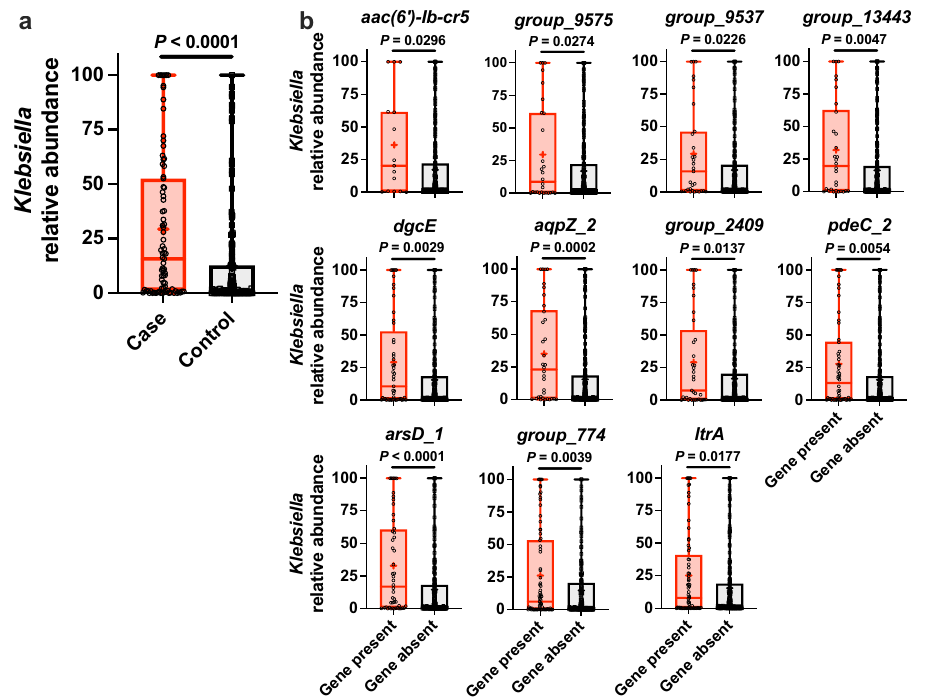
Fig. 3 | Speci fi c infection-associated genes are associated with increased Kleb- siella gut relative abundance. a Comparison of Klebsiella gut relative abundance in patient rectal swabs between cases ( n =83) and controls ( n =149, mean dis- played, **** P- value ≤ 0.00005, two-sided Student ’ s t -test) and b in patient rectal swabs strati fi ed by gene presence/absence (25% percentile and 75% percentile bound the box, median displayed as line, mean displayed as plus sign, and range displayed as whiskers, * P- value ≤ 0.05, ** P- value ≤ 0.005, *** P -value ≤ 0.0005, **** P- value ≤ 0.00005, two-sided Student ’ s t -test). Each data point represents a